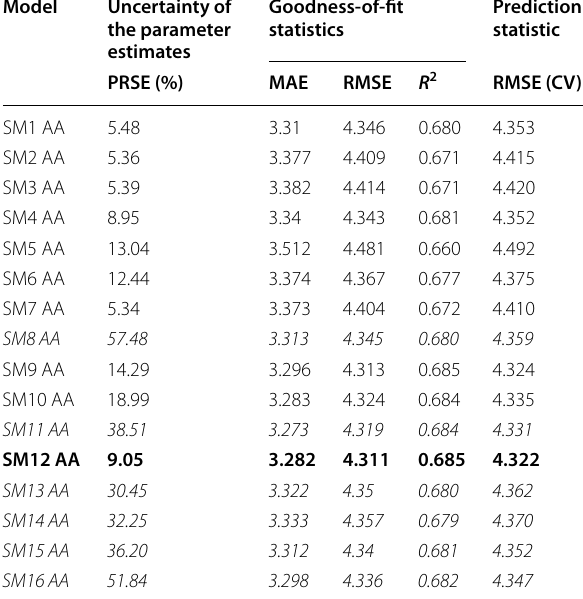
Bold, selected model. Italic, models with PRSE >